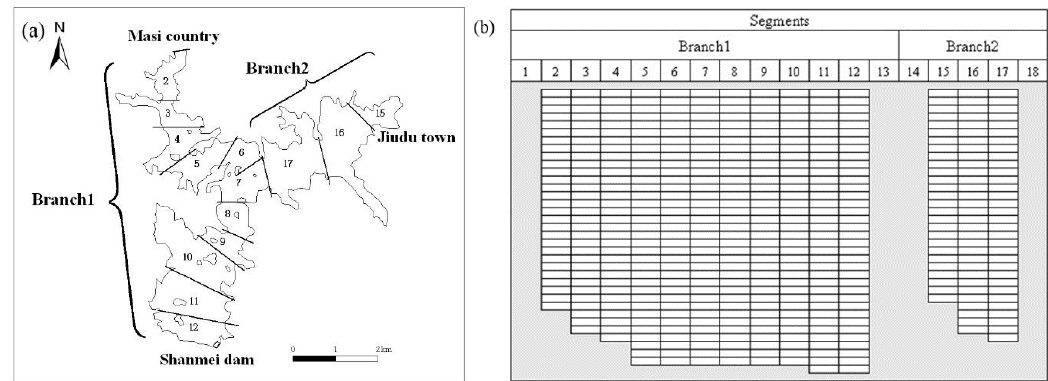
Figure 2. ( a ) Segmentation and ( b ) vertical computational grids of the Shanmei Reservoir.